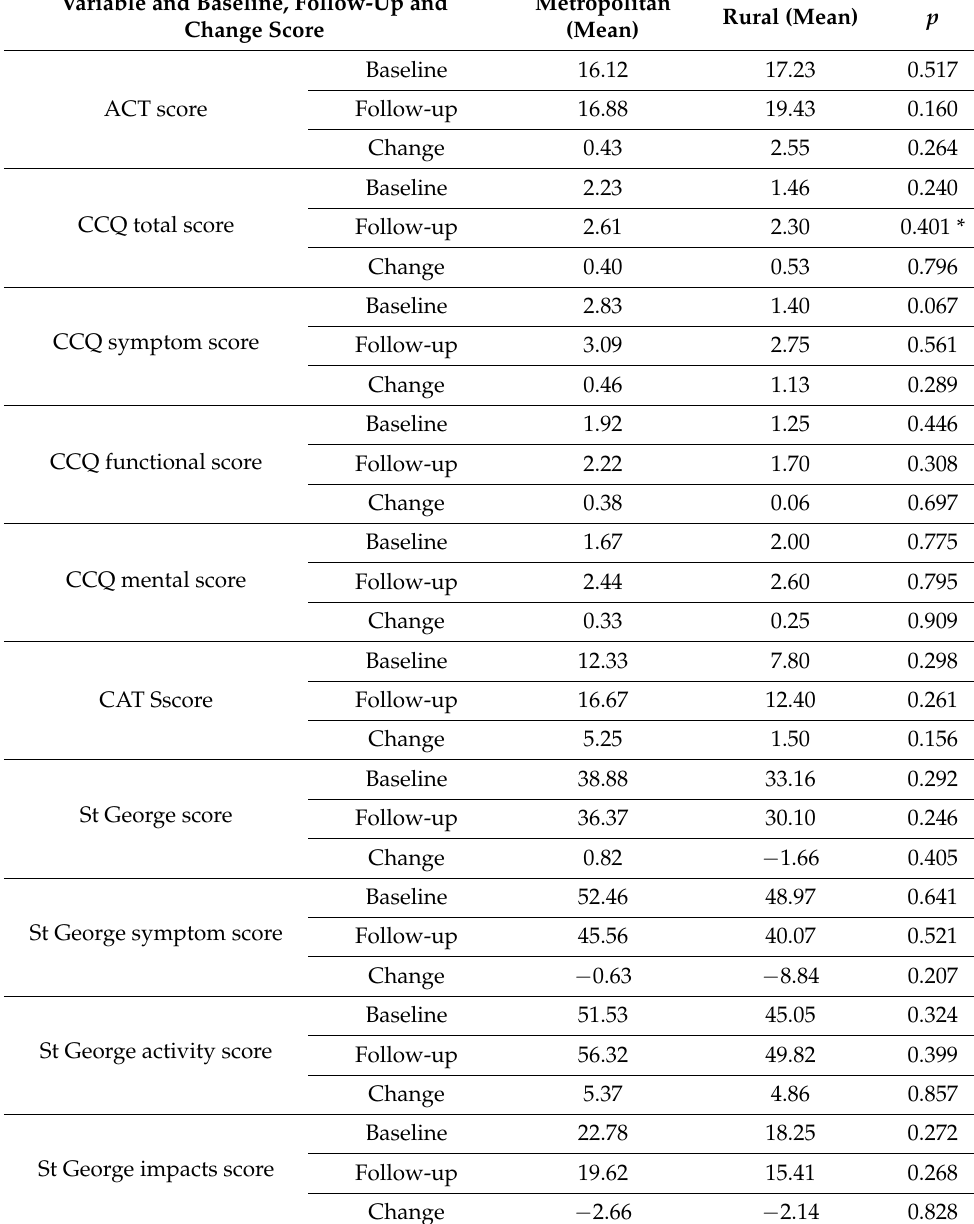
Table 4. Differences in various validated test scores at baseline and follow-up between metropolitan and rural